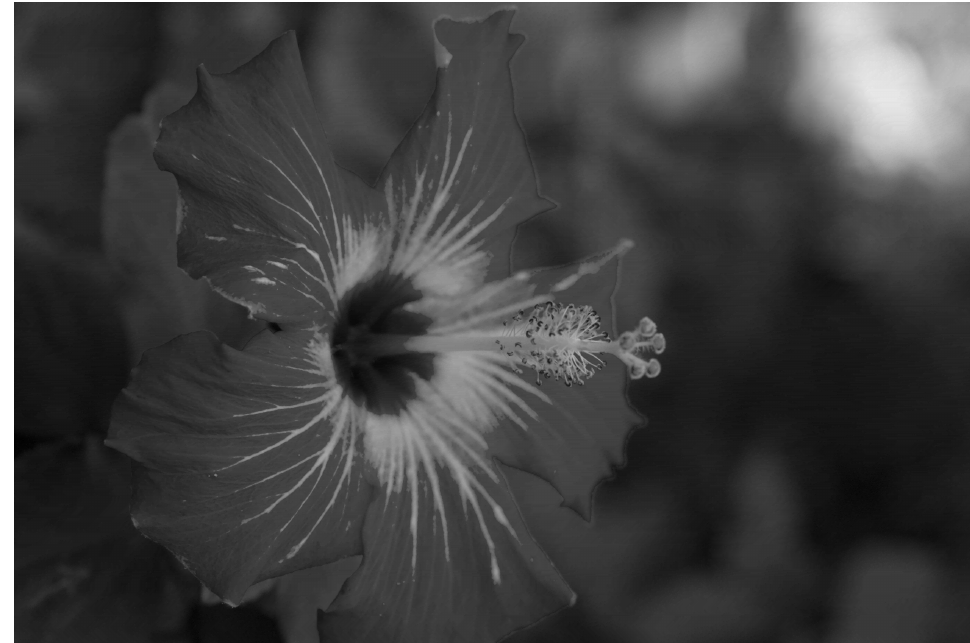
Figure A2. Decoded picture of a flower (8-bit, 2268 × 1512) from the Rawzor dataset using LOCO- ANS6 with NEAR = 3. bpp: 0.251. PSNR: 44.16